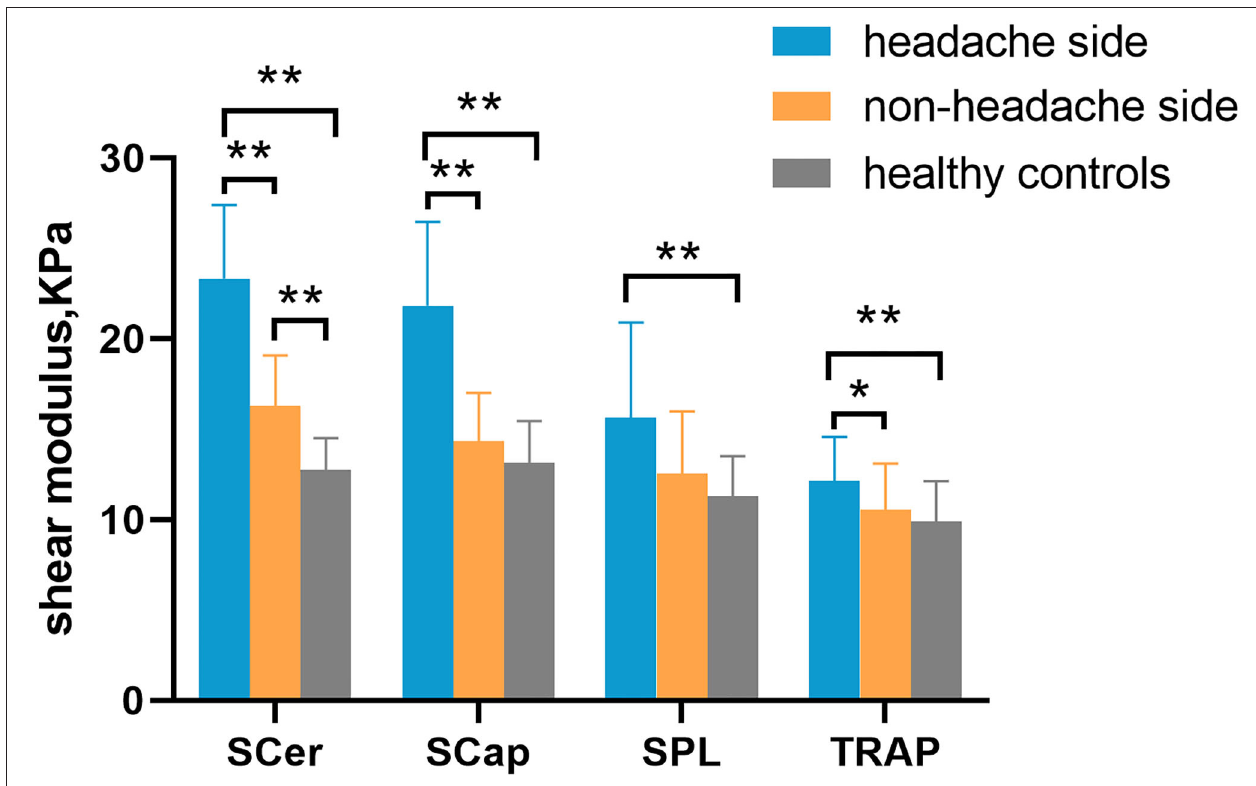
FIGURE 2 | Comparison of superficial cervical extensor stiffness between patients with CEH and healthy controls. Cervical extensor muscle stiffness on the headache side was higher than that on the non-headache side and in healthy controls. * p < 0.05 and ** p < 0.01. TRAP, trapezius; SPL, splenius capitis; SCap, semispinalis capitis; SCer, semispinalis